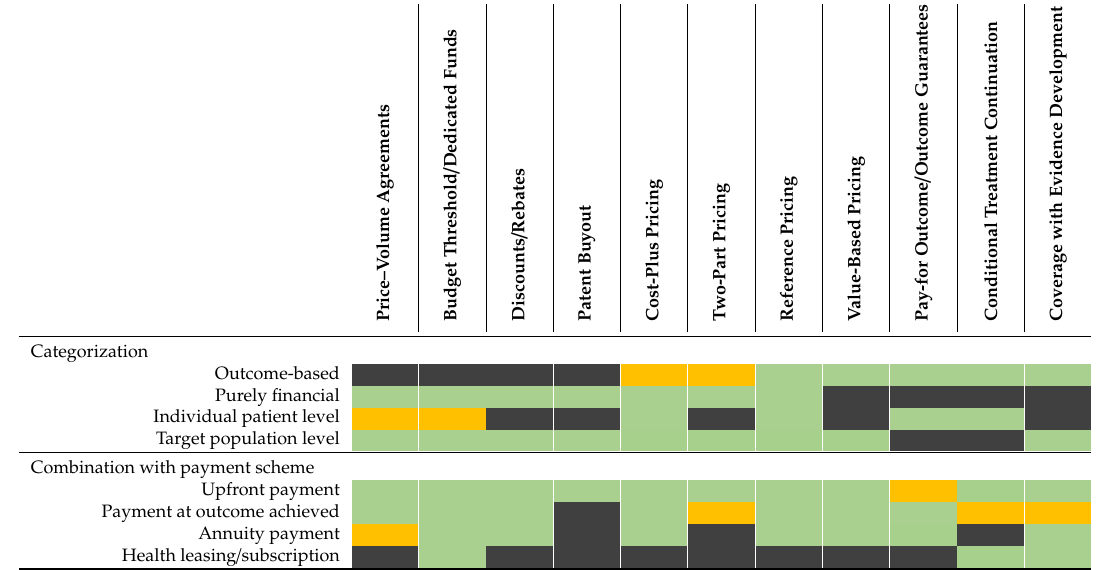
Table 3. Applicability and feasibility of included managed entry agreements in di ff erent settings including an assessment of the feasibility of combinations of